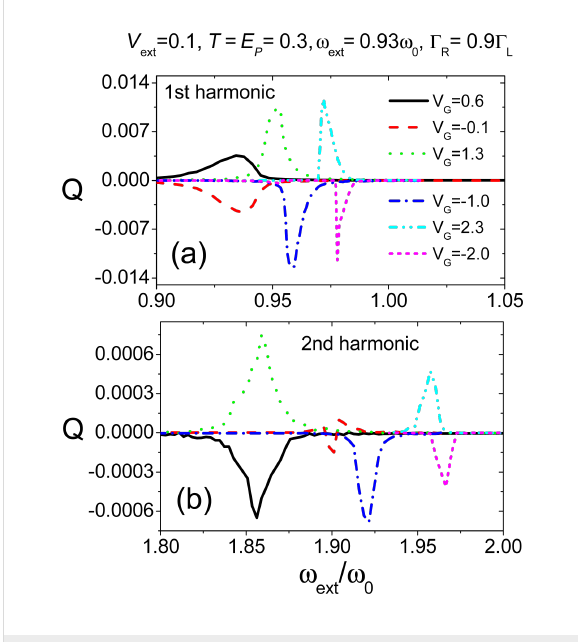
Figure 13: Single-parameter charge pumped at zero bias. Panel (a): Charge Q (in units of e ) as a function of the external frequency in the interval close to 1 × ω 0 with varying the static gate V G . Panel (b): Charge Q (in units of e ) as a function of the external frequency in the interval close to 2 × ω 0 with varying the static gate V G . Adapted and reproduced with permission from [79], copyright 2013